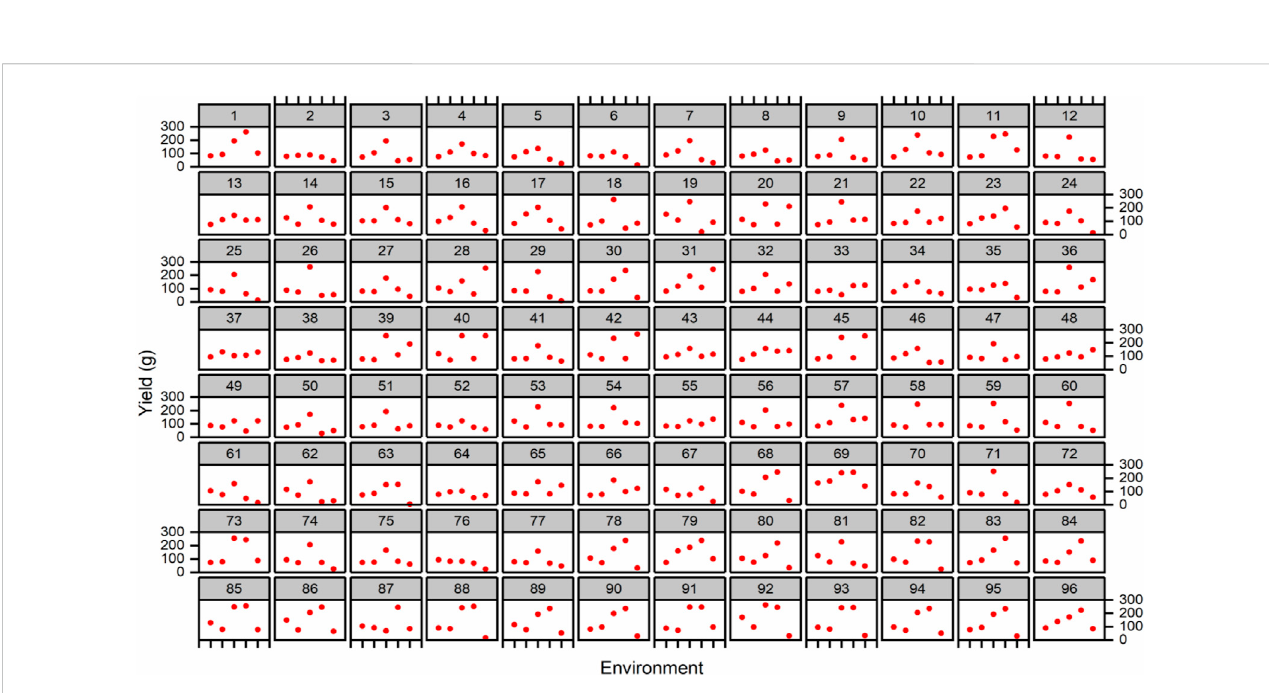
FIGURE 4 Trellis plots for average yield (g/plot) across fi ve environments. Genotypes are coded as 1 –